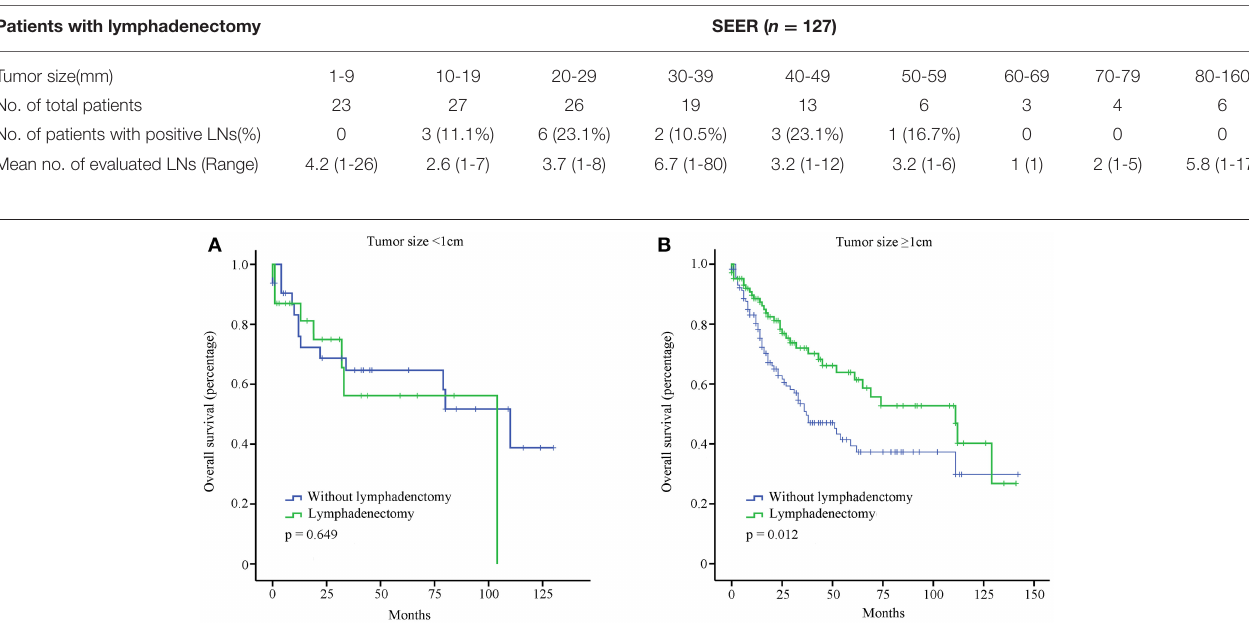
FIGURE 3 | OS of GBA patients stratified by tumor size and surgical treatment using Kaplan-Meier analysis. (A) Tumor size < 1cm; (B) Tumor size ≥ 1cm.